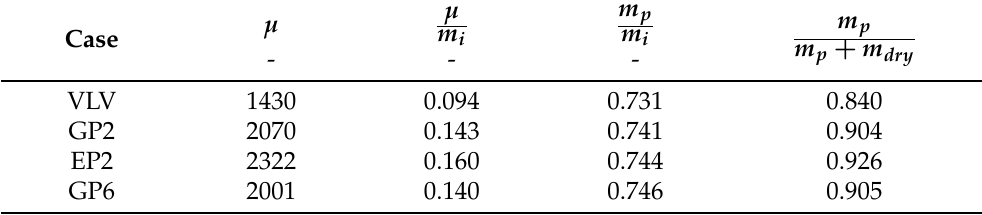
Table 13. Normalized ratios for the reference (VLV) and robust optimized solutions. GP2 and EP2 are the solutions for gas pressurized and electric turbo pump feed system employing simpler 2-parameter robust-based approach. GP6 reports the mass ratios for the 6-parameter robust-based